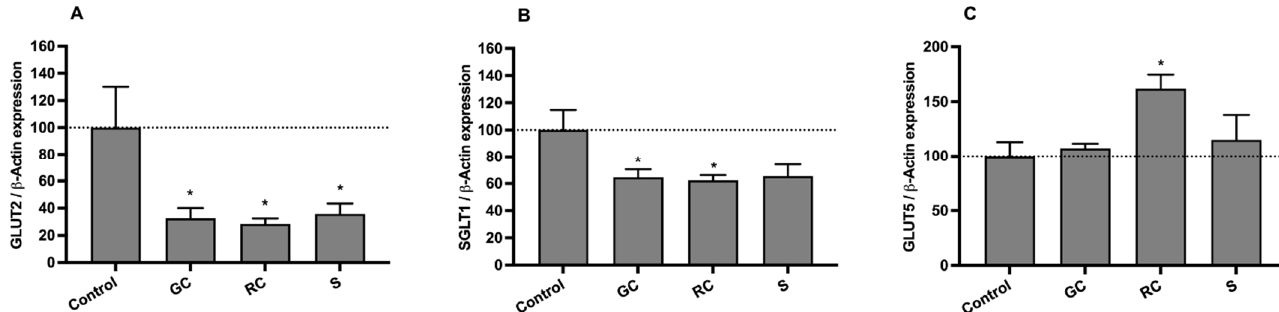
Figure 6. Quantification of mRNA levels of ( A ) facilitative glucose transporter 2 (GLUT2); ( B ) sodium-dependent glucose transporter 1 (SGLT1); and ( C ) facilitative glucose transporter 5 (GLUT5), by RT-qPCR, in Caco-2 cells after a treatment of 24 h with green coffee (GC), roasted coffee (RC), and coffee silverskin (S) extracts (all at 1 mg/mL; n = 5–6) or the respective solvent (control, DMSO; n = 5–6). The results are shown as the expression of SGLT1, GLUT5, or GLUT2 in relation to β -actin (arithmetic means ± SEM). *, significantly different from control ( p < 0.05; Student’s t -test).